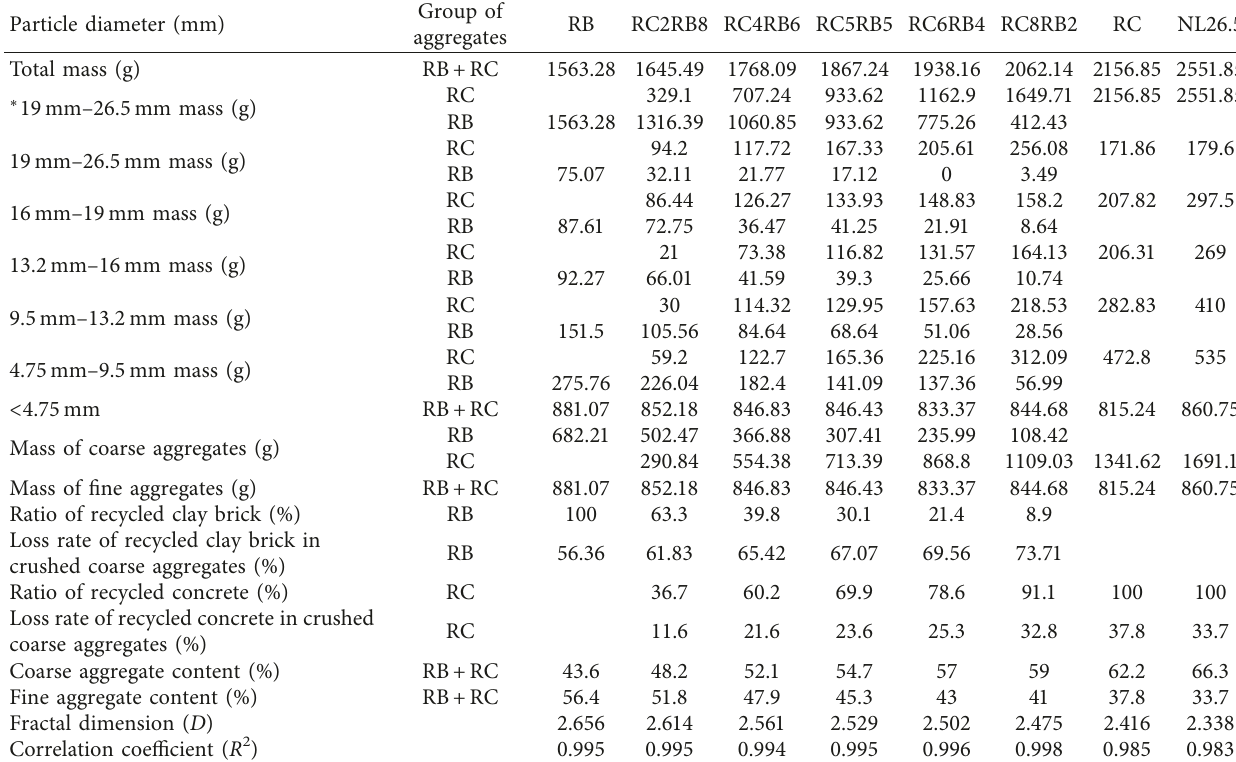
Table 2: Statistical table of crushing and screening of recycled mixed aggregates.